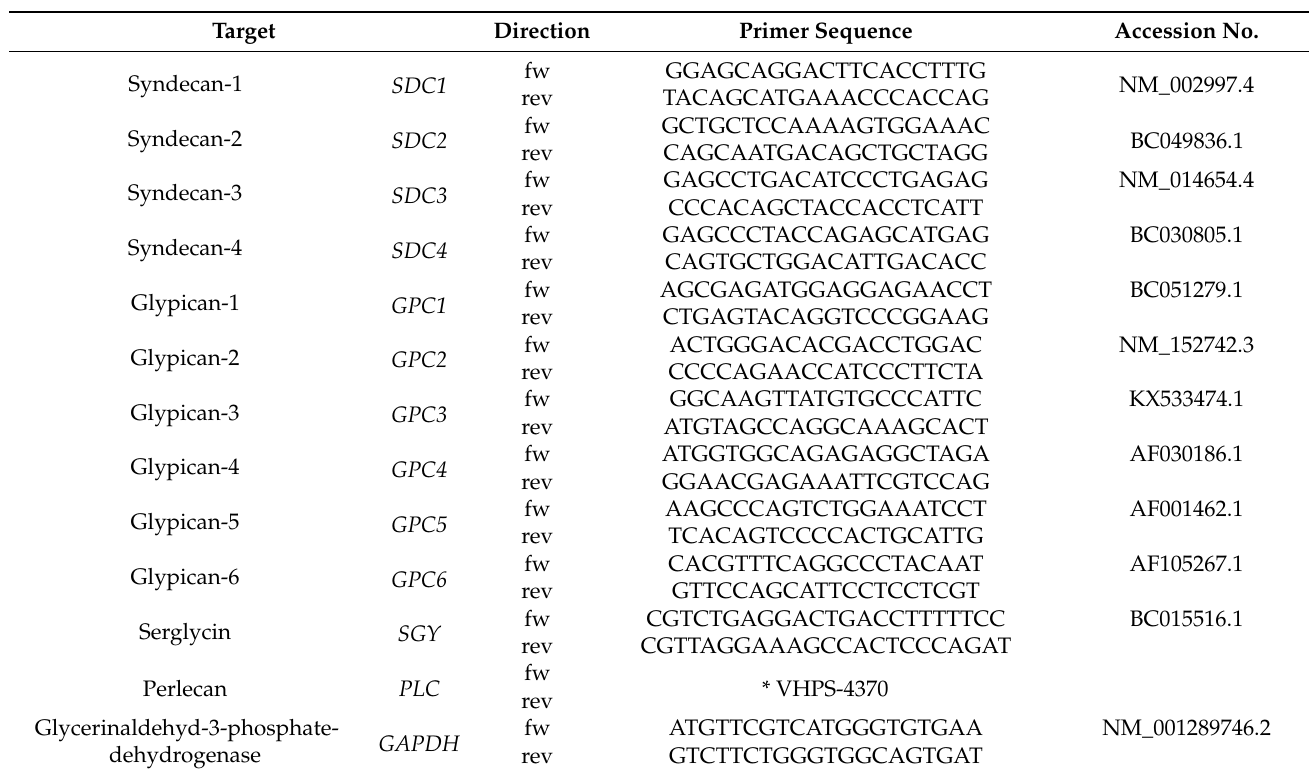
Table 3. List of primer sequences and gene accession numbers used for primer design for qPCR anal- ysis of PGs; Abbreviations: SDC, syndecan; GPC, glypican; PLC, perlecan; GAPDH, Glycerinaldehyd-